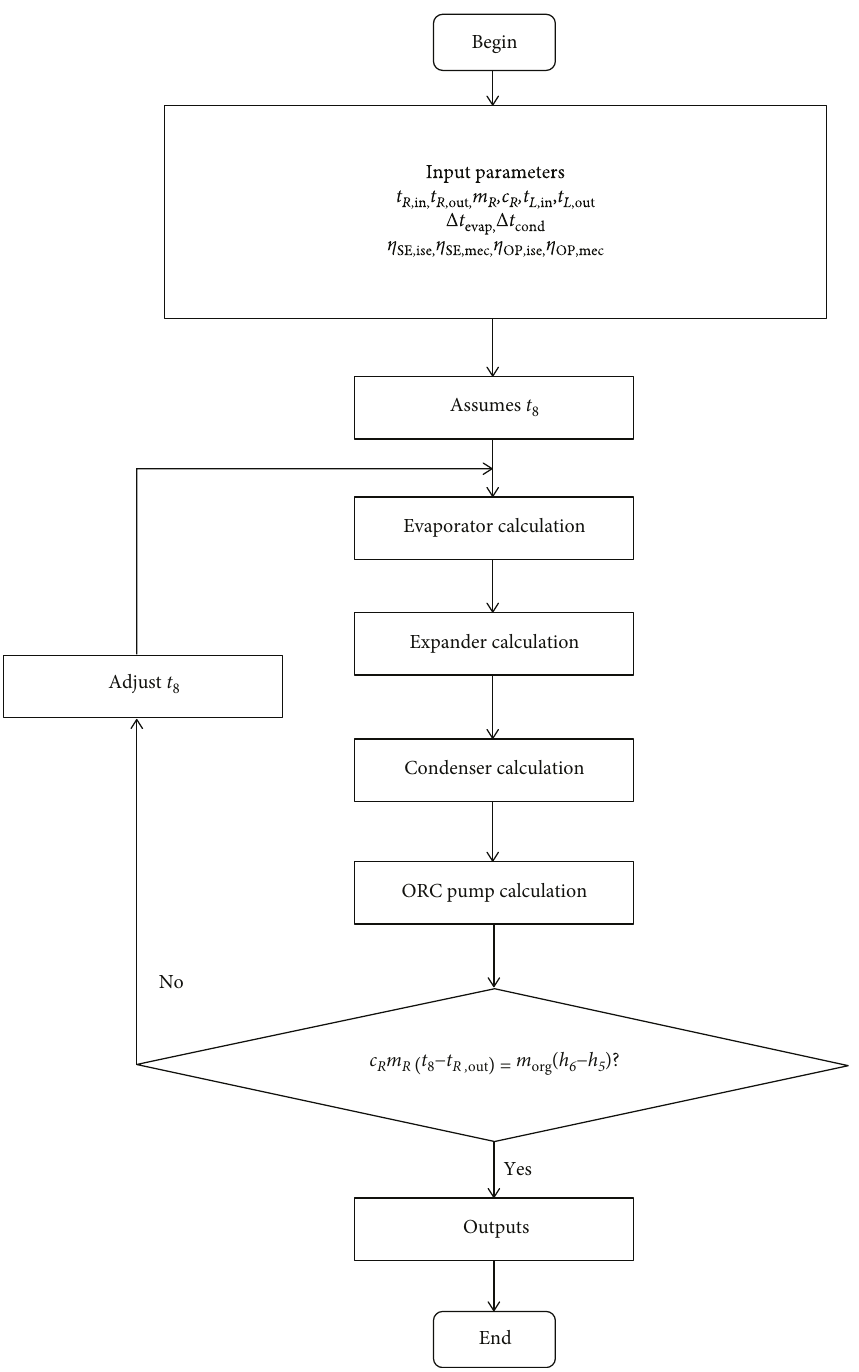
Figure 5: The calculation fl ow chart of the ORC